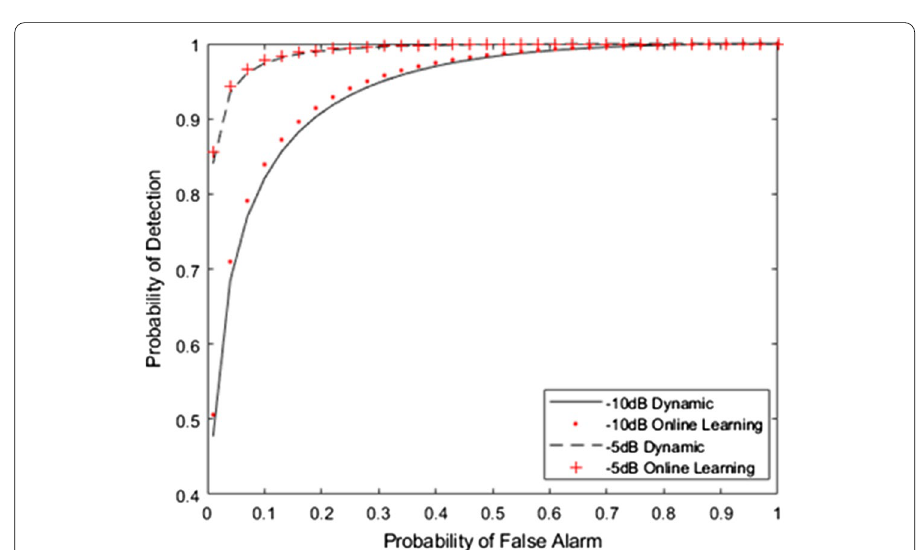
Fig. 12 ROC ( P d vs P fa ) of matched filter detection sensing under Rician fading channel ( K